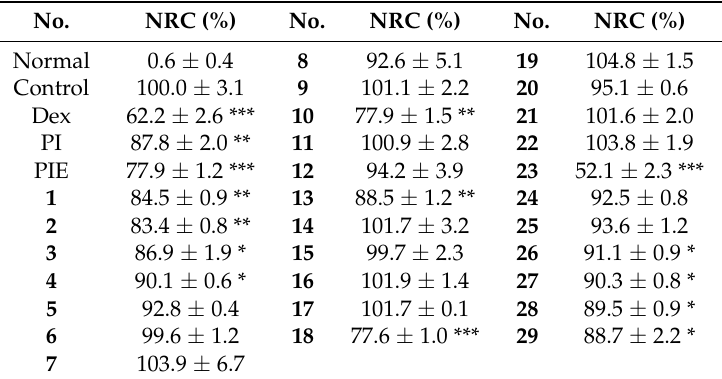
Table 5. Inhibitory effects of positive control, PI, PIE and compounds 1 – 29 obtained from the aerial parts of P. indica on NO production in RAW 264.7 macrophages. No. NRC (%)